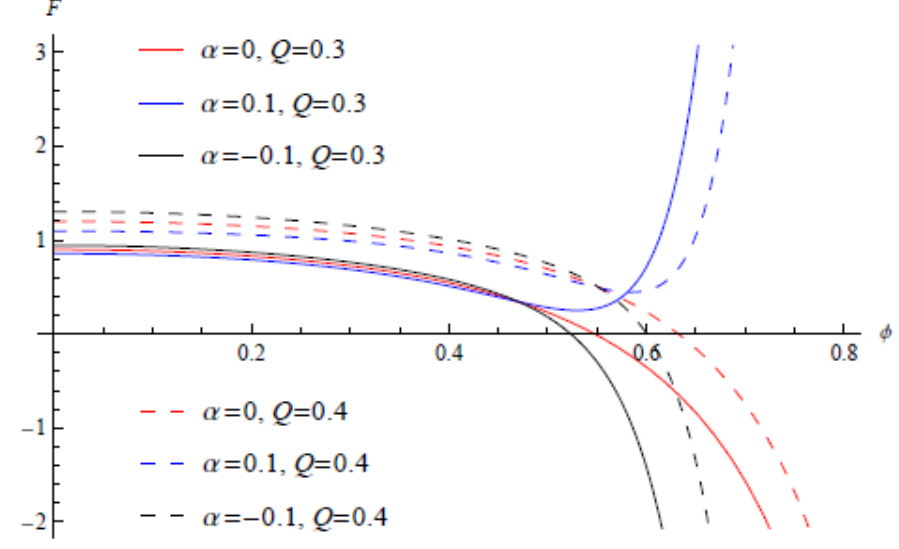
Fig. 5. Friction force vs. amplitude ratio for various values of , Q